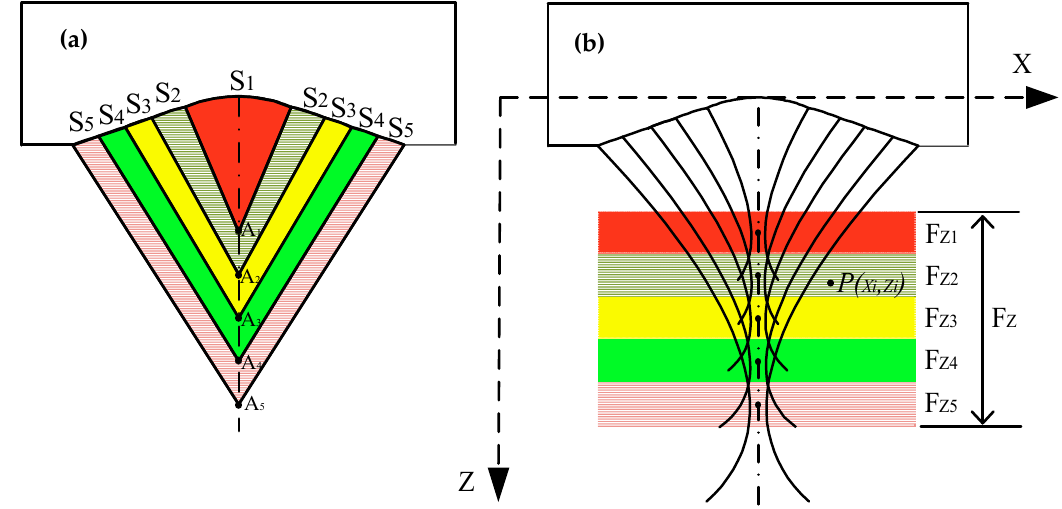
Figure 3. ( a ) Distribution of multifocal point, ( b ) distribution of focal zones. The point P(x i , z i ) is located in the focal zone will get the good image. The x i represents the distance in the X-axis, z i is the depth of point P in the Z-axis.